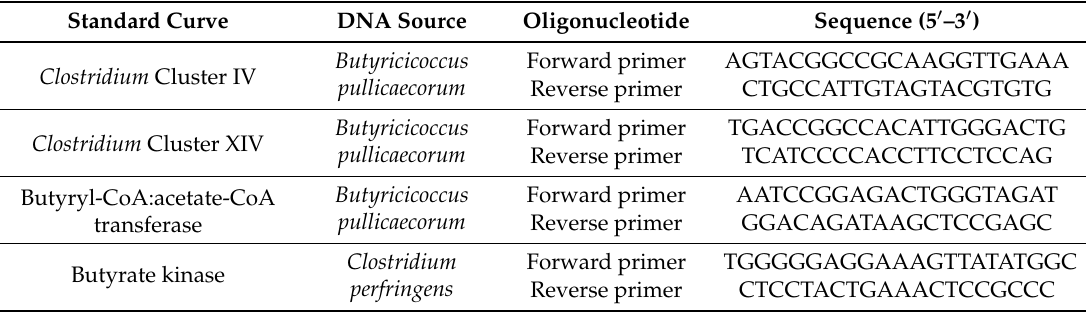
Table 1. Primers used for construction of standard curves for quantification of the butyrate producing capacity present in fecal